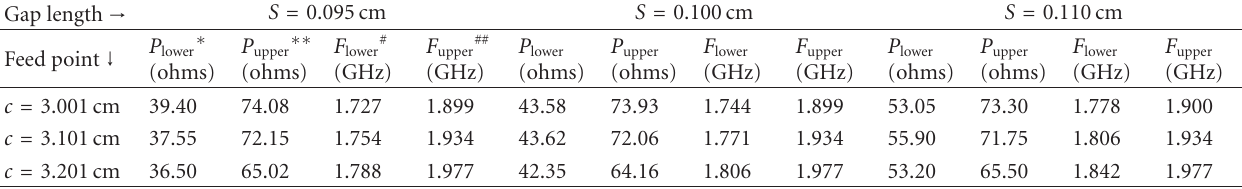
Table 2: Peak value of input impedance, resonance frequency for upper and lower band for di ff erent feed locations. Gap length → S = 0.095 cm